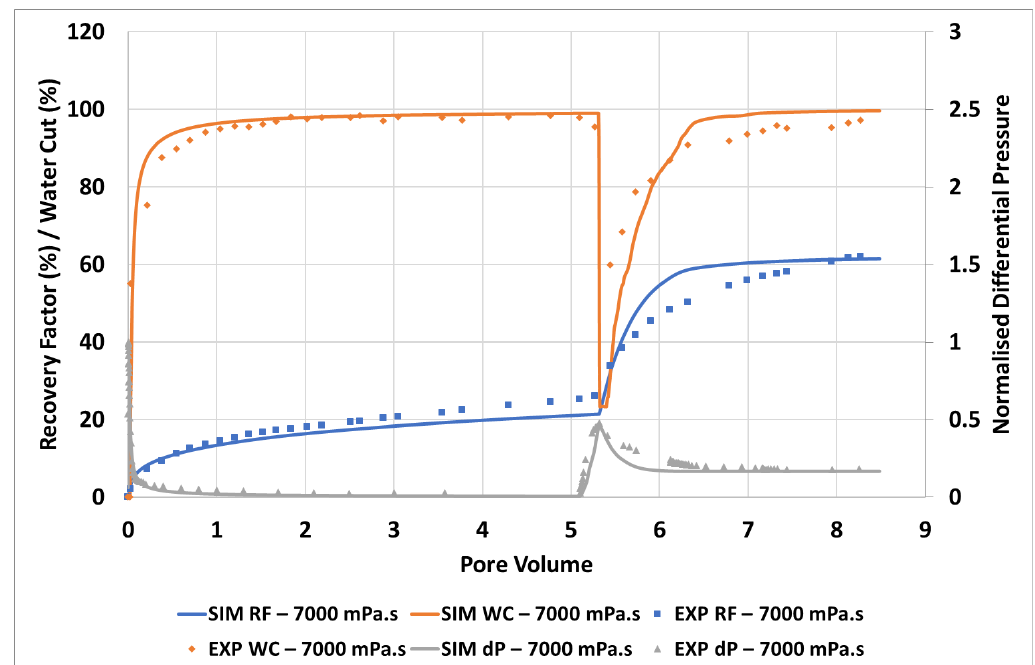
Figure 7. Simulation match of the unstable displacement of 7000 mPa.s oil.